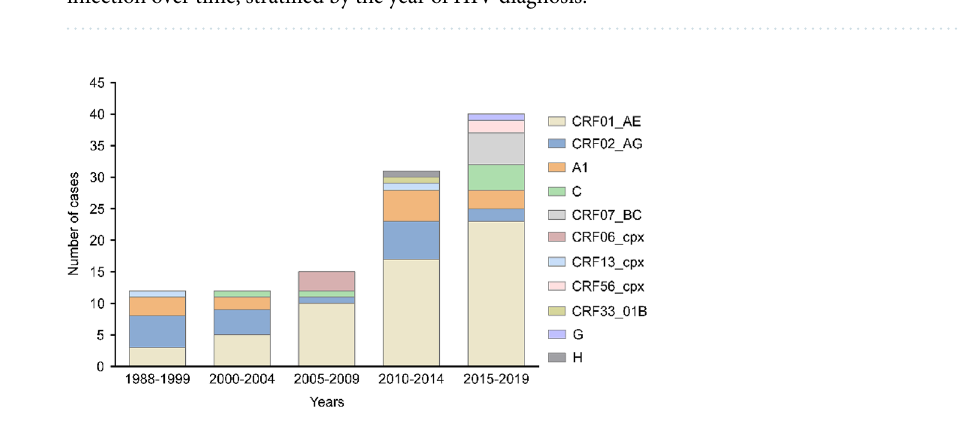
Figure 2. Changes in the distribution of non-B HIV-1 subtypes among 110 patients with HIV infection over time, stratified by the year of HIV